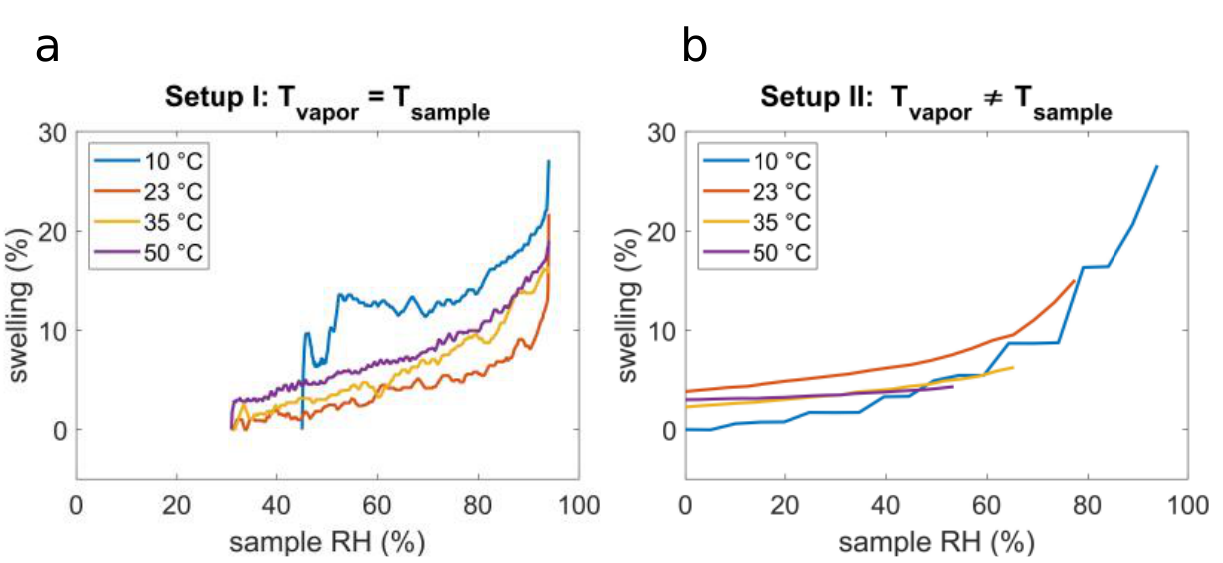
Figure 5. Swelling of the temperature responsive hydrogel at different temperatures and humidity levels, performed with ( a ) setup I, the custom-built interferometer within the environmental chamber, where T vapor = T sample , or ( b ) setup II, the spectroscopic ellipsometry, where T vapor ≠ T sample. In Figure 5b, the swelling obtained via spectroscopic ellipsometry (setup II), in the presence of thermal gradients, is plotted versus the relative humidity of the sample surface calculated with the Arden-Buck Equation (8) in the range of 0–95%. Again, with rising relative humidity, an increase in swelling at all temperatures can be observed. For a sample temperature of 10, 23, 35, and 50 ◦ C and incoming water vapor of 23 ◦ C and 78% RH , the max humidity reached at the sample surface was calculated to be 94, 77, 65, and 53%, which resulted in a thickness increase of 27, 15, 6, and 4%,